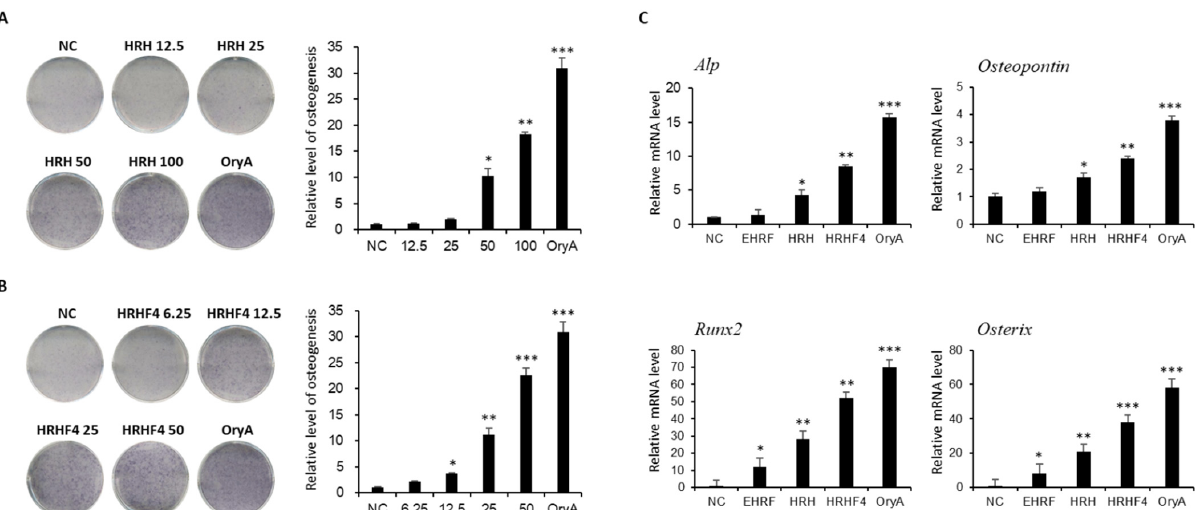
Figure 2. Evaluation of the effects of the hexane-soluble (HRH) and HRHF4 fractions on osteogenesis. ( A ) Concentration-dependent stimulatory effect of the hexane-soluble fraction from an ethanol